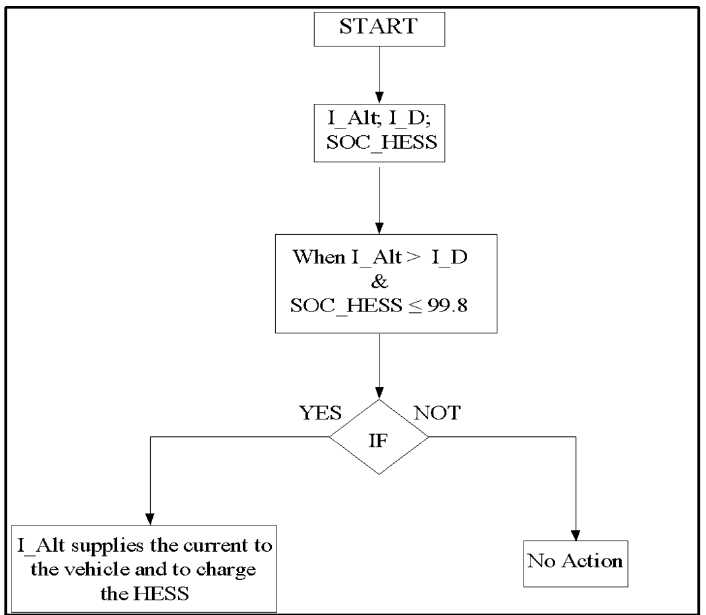
Figure 5. Flow chart of the proposed BMS in HESS during charging mode.